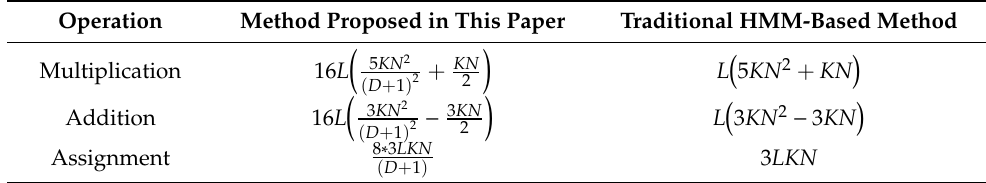
Table 1. Comparison of the approximate calculation amount of the frequency line extraction process using the method proposed in this paper and traditional HMM-based